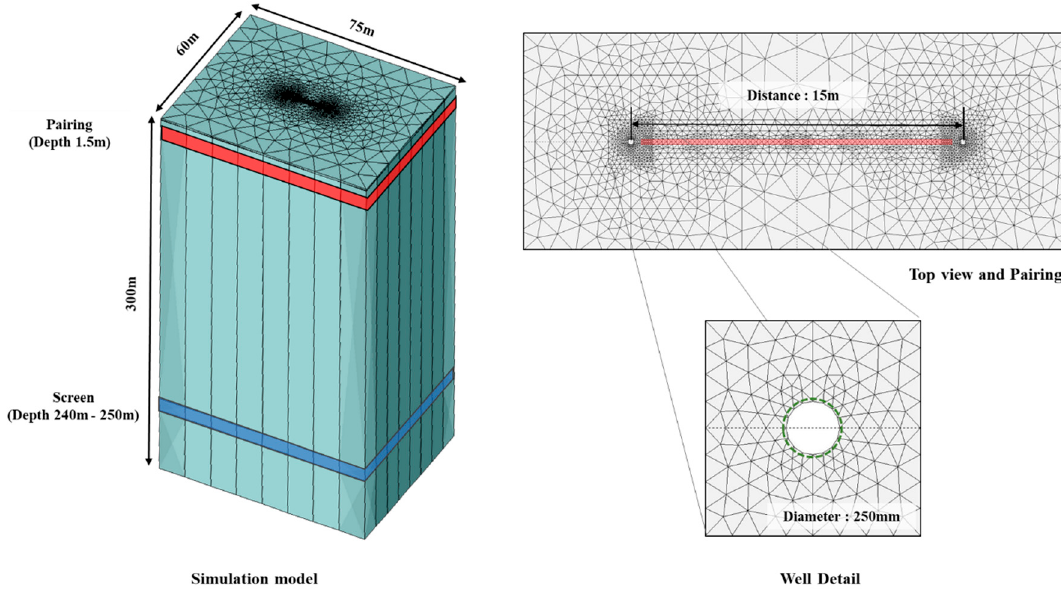
Table 6. Ground conditions of numerical analysis model.